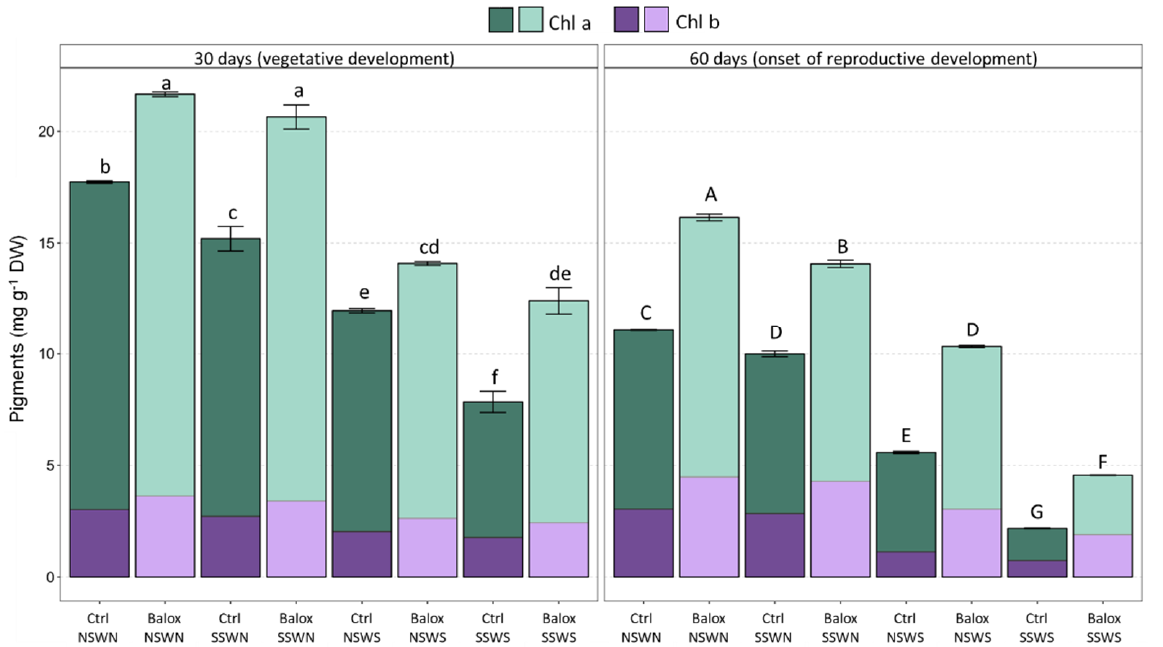
Figure 4. Total chlorophyll content in tomato plants subjected to increasing salinity by different combinations of saline or non-saline soil and irrigation water; the plants were treated, or not, with the biostimulant containing polyphenols at 1.4% ( w / w ) and glycine betaine at 3.0% ( w / w ) at a dose of 0.4 mL L − 1 of irrigation water. The control treatments without biostimulant (Ctrl) and with biostimulant (BALOX ® ) are defined as follows: (i) NSWN: Non-saline soil (EC = 2.28 dS/m) and non-saline water (EC = 0.91 dS/m); (ii) SSWN: Saline soil (EC = 8.55 dS/m) and non-saline water (EC = 0.91 dS/m); (iii) NSWS: Non-saline soil (EC = 2.28 dS/m) and saline water (EC = 10.50 dS/m); (iv) SSWS: Saline soil (EC = 8.55 dS/m) and saline water (EC = 10.50 dS/m). The evaluation periods: 30 days and 60 days of treatments. The values are the means ± SE ( n = 3). Different letters above the bars (lowercase for 30 days and capital for 60 days treatments) indicate significant differences between treatments, according to the ANOVA test ( p < 0.05). Statistical analyses were performed in- dependently for the two treatment periods.